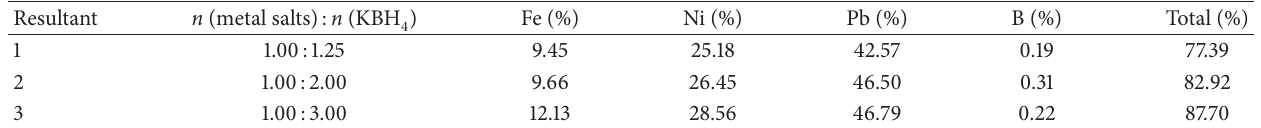
Figure 3: Transmission electron micrographs of the Fe-Ni-Pb-B alloy nanoparticles. Table 1: The testing data of ICP of the